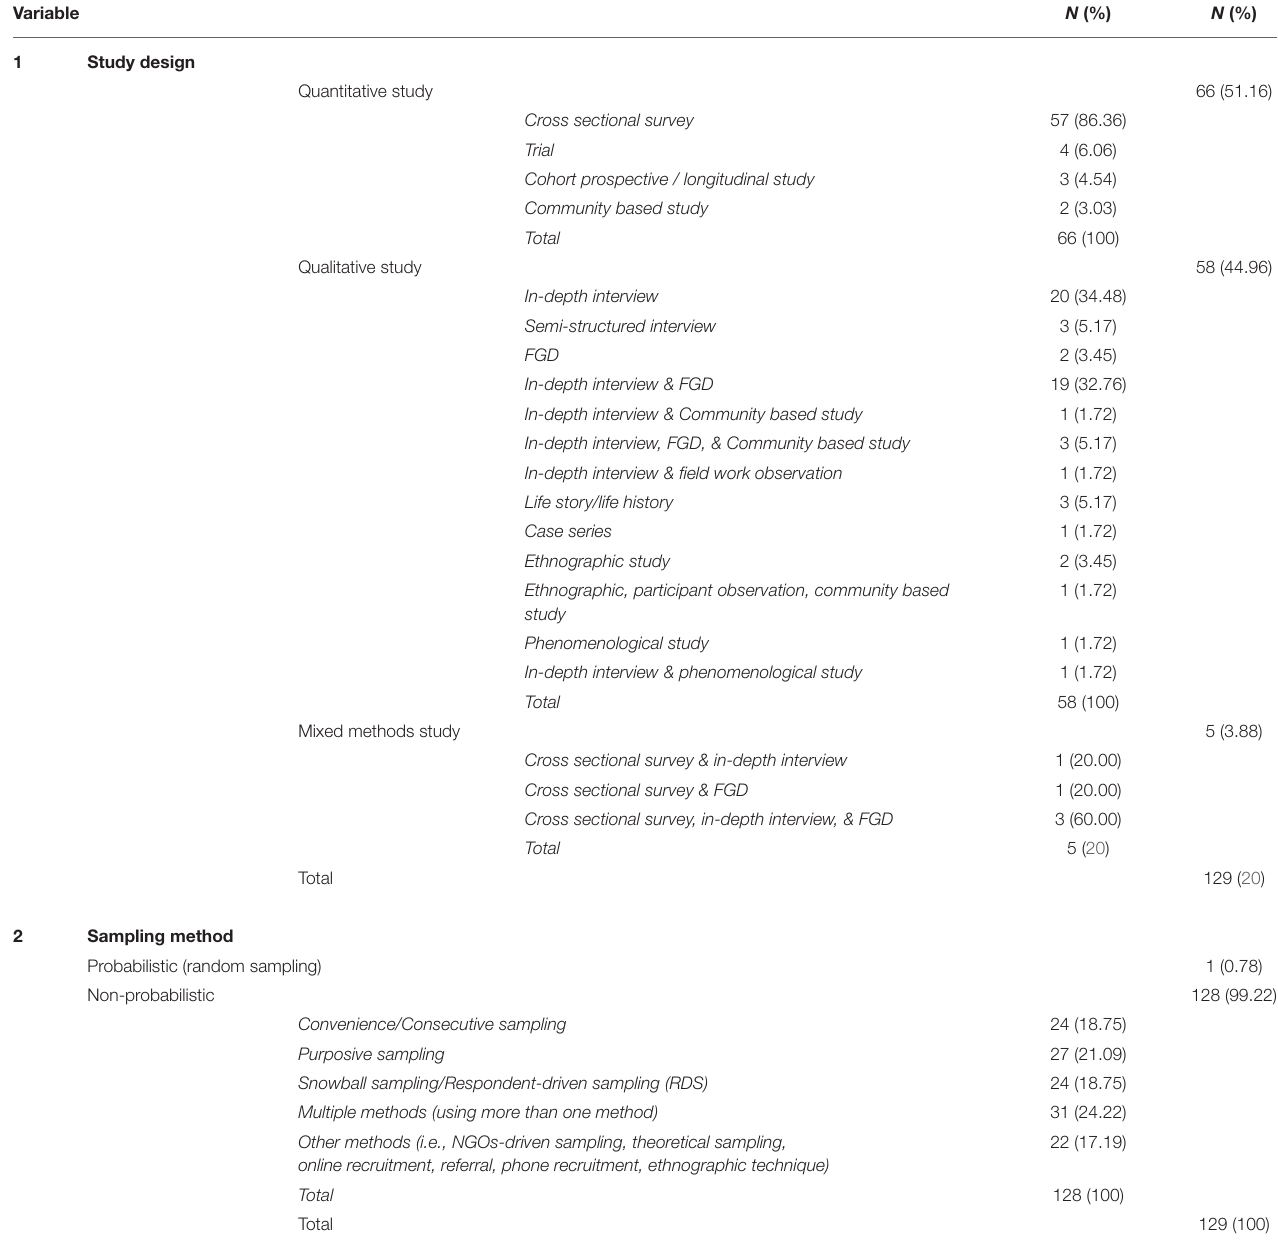
TABLE 1 | Overview of study characteristics.